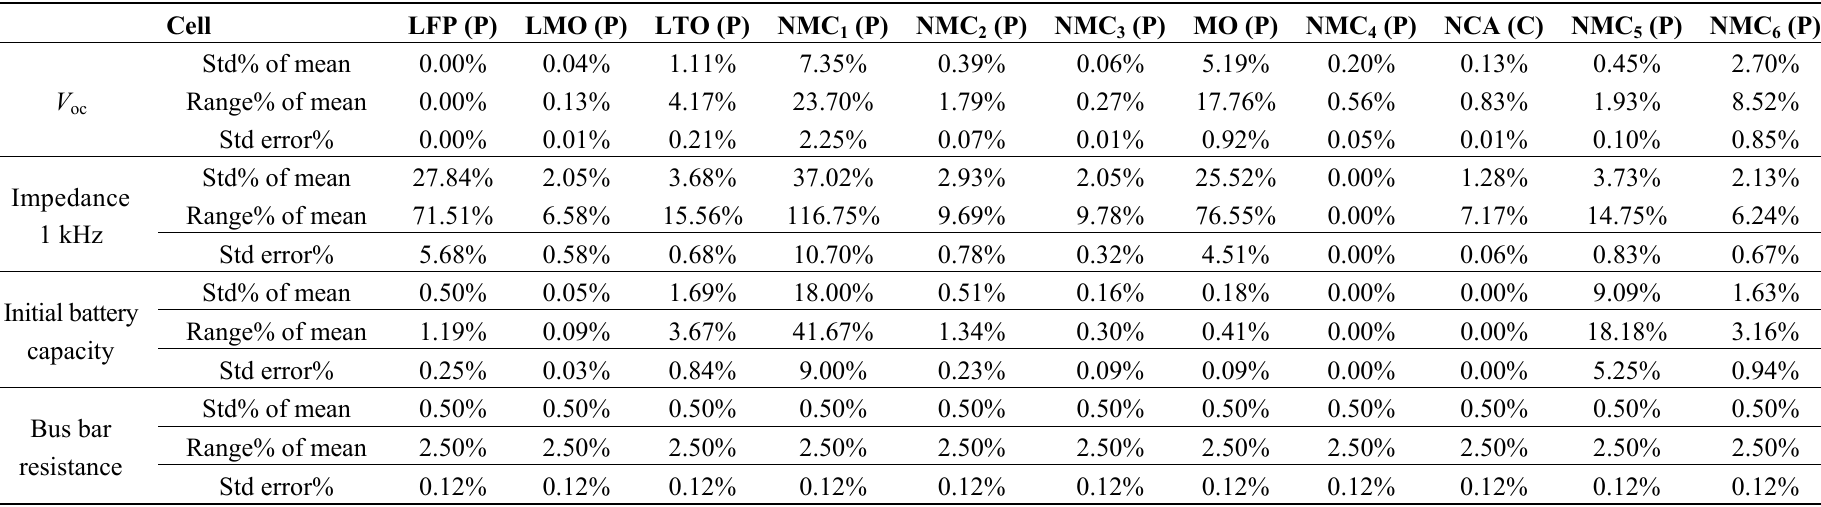
Table 1. Statistical analysis of WMG battery laboratory initial characterization of received goods data at 25 °C. Std means standard deviation; MO indicates a mixed oxide electrode cell; P indicates pouch cells; and C indicates cylindrical cells. LMO: manganese spinel; LTO: lithium titanate; and NCA: lithium nickel-cobalt-aluminium